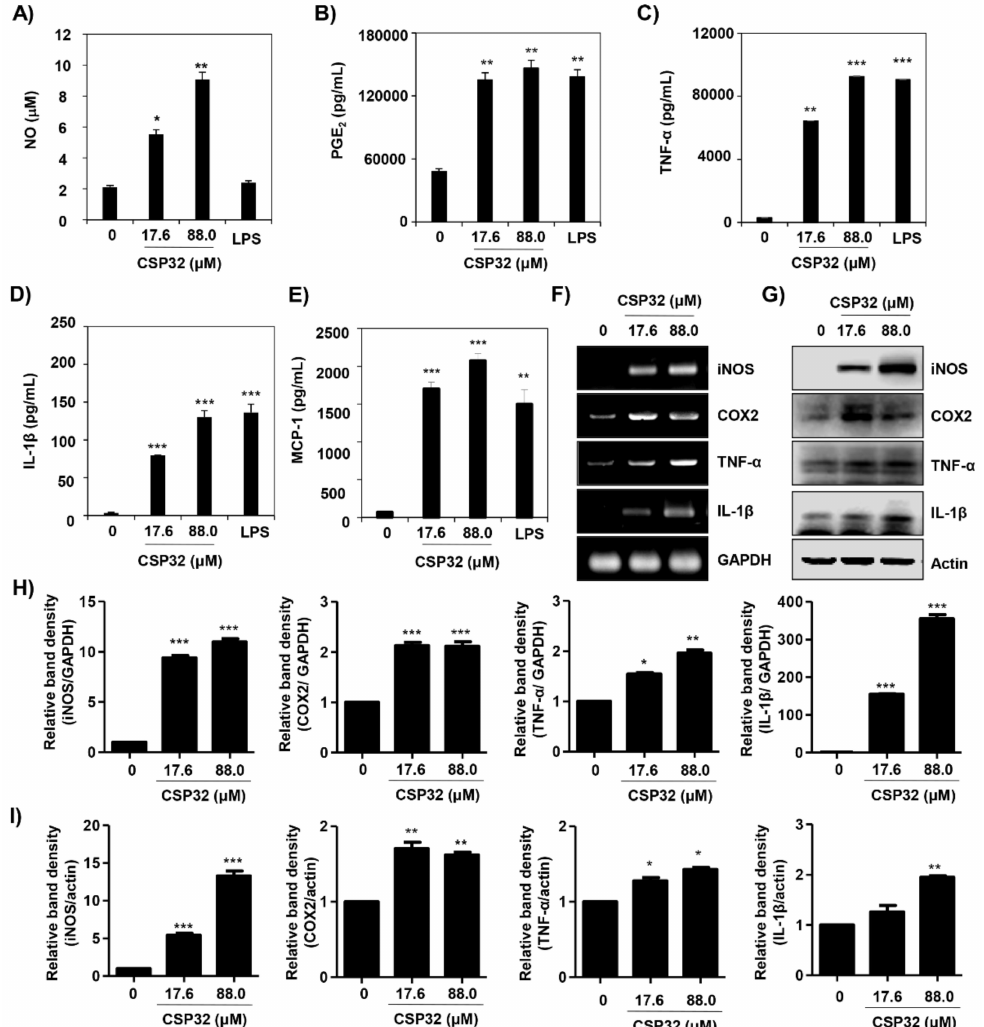
Figure 3. CSP32 increased the levels of markers for M1 macrophages. Cells were treated with the indicated concentrations of CSP32 and LPS for 24 h. ( A ) The amount of NO in the cell supernatant was measured using Griess reagents. The levels of PGE 2 ( B ), TNF- α ( C ), IL-1 β ( D ), and MCP-1 ( E ) in the culture supernatants were measured by ELISA kits. Data are expressed as the mean ± SD ( n = 4). * p < 0.05, ** p < 0.01, and *** p < 0.001 compared with the control. mRNA ( F ) and protein ( G ) expression of markers of M1 macrophages, including iNOS, COX-2, TNF- α , and IL-1 β . GAPDH and β -actin were used as internal controls for RT-PCR and western blotting. Quantitative analysis of mRNA ( H ) and protein ( I ) expression. The expression of each protein was indicated as a fold change relative to the control. Data are expressed as the mean ± SD ( n = 3). * p < 0.05, ** p < 0.01 and *** p < 0.001 compared with the